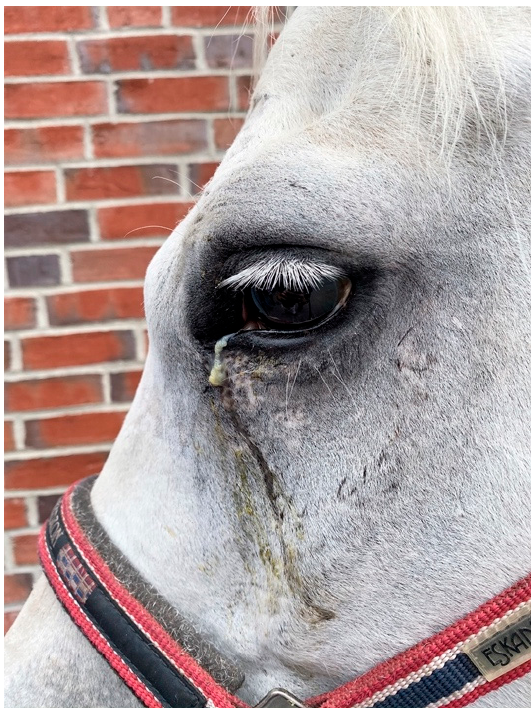
Figure 1. Picture of a horse with moderate, purulent epiphora secondary to idiopathic suture exostosis.